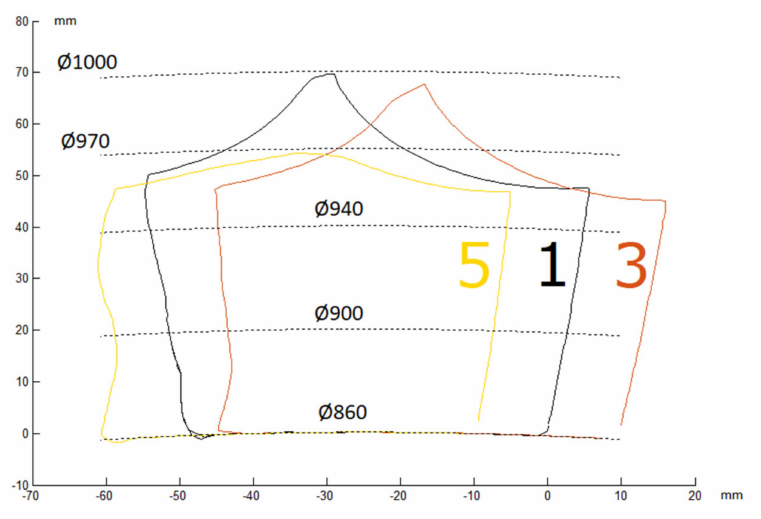
Figure 11. Summary of geometries of the first row, third row, and fifth row